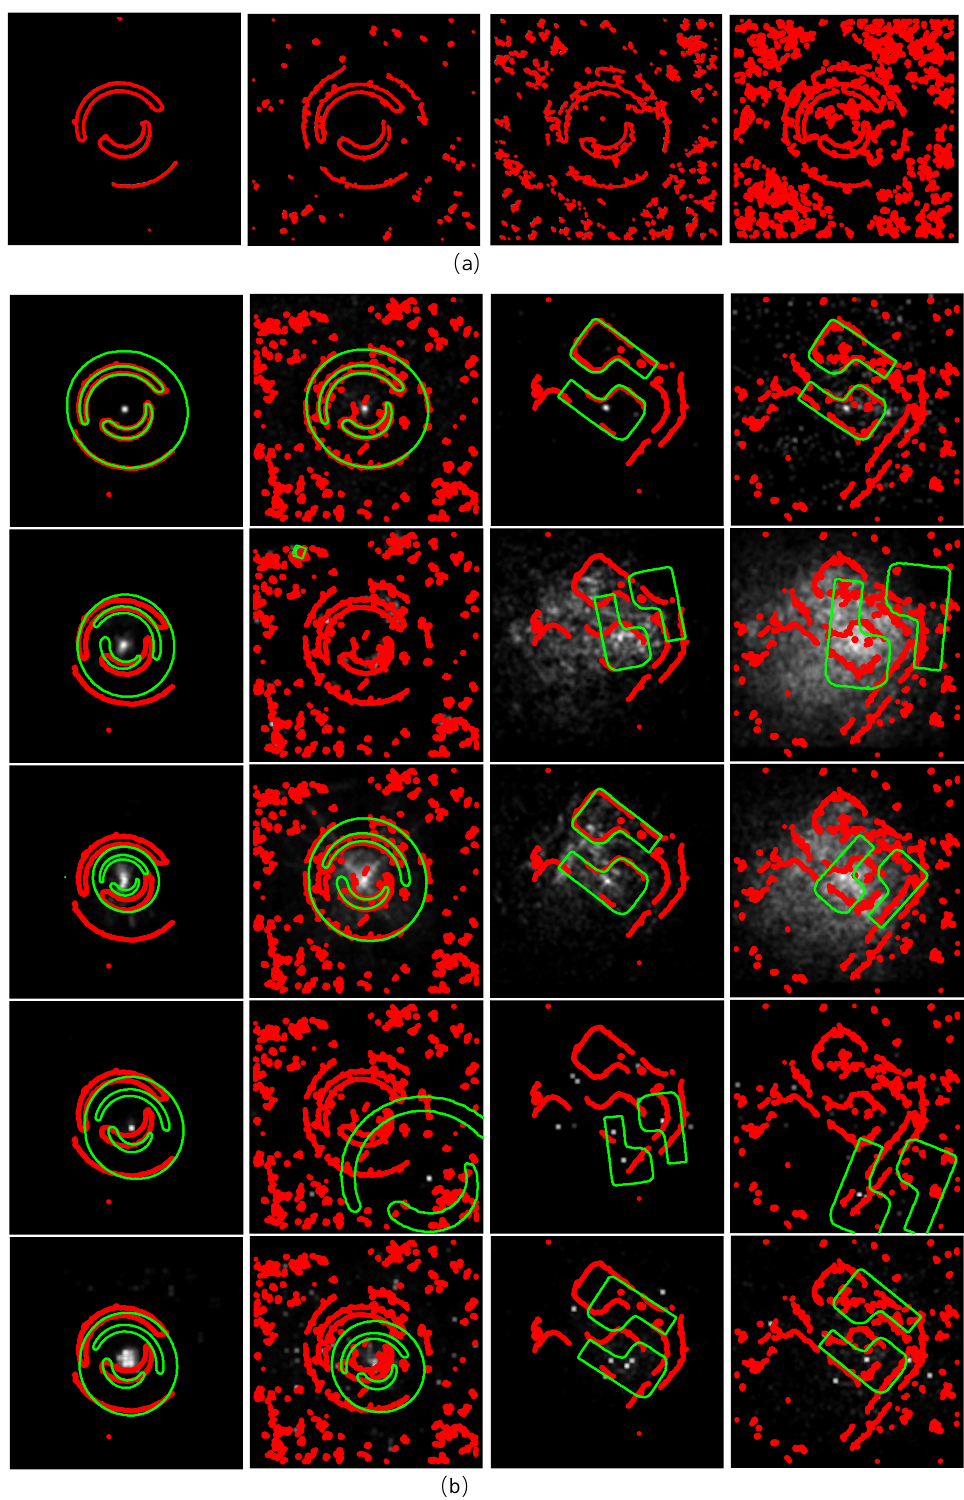
Figure 13. ( a ) S2 under salt and pepper noise densities of 0.1, 0.2, 0.3, and 0.4 (left to right). ( b ) Demo of positioning results for the proposed RV-GHT, the GDP-GHT, the PI-GHT, the GFGHT, and the FRGHT (in top-down order) for S2 and S8 with a noise density of 0.1 and